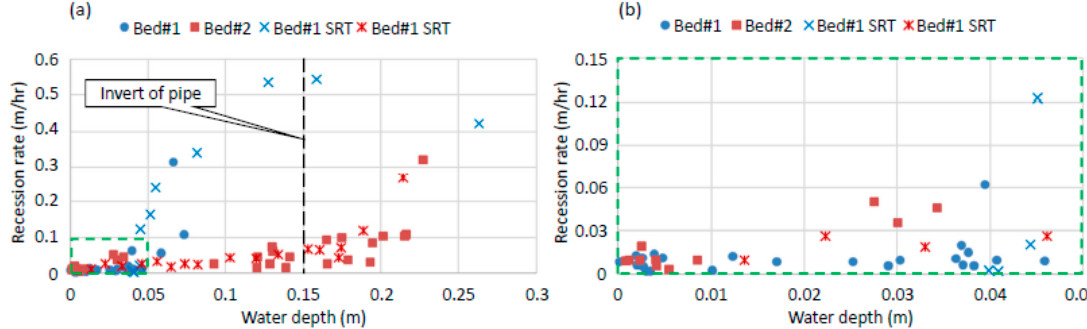
Figure 6. ( a ) Water depth and associated water level recession rate for the two infiltration beds, and ( b ) details of the region enclosed by the dash line rectangle in ( a ).